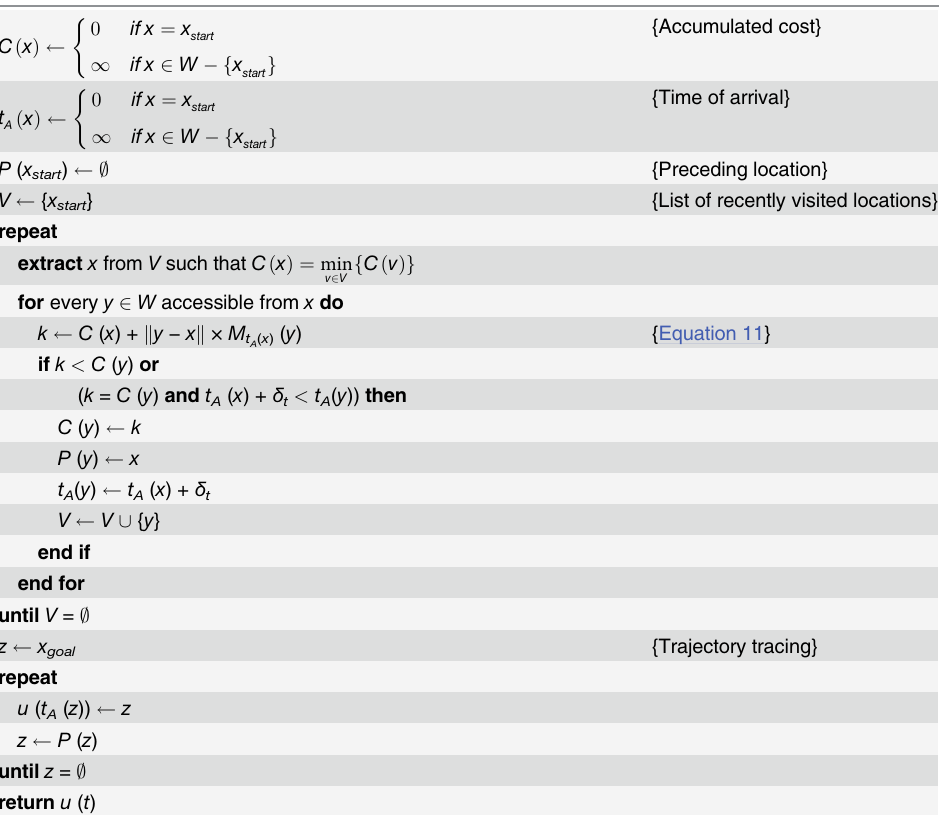
Table 1. Time-dependent Dijkstra